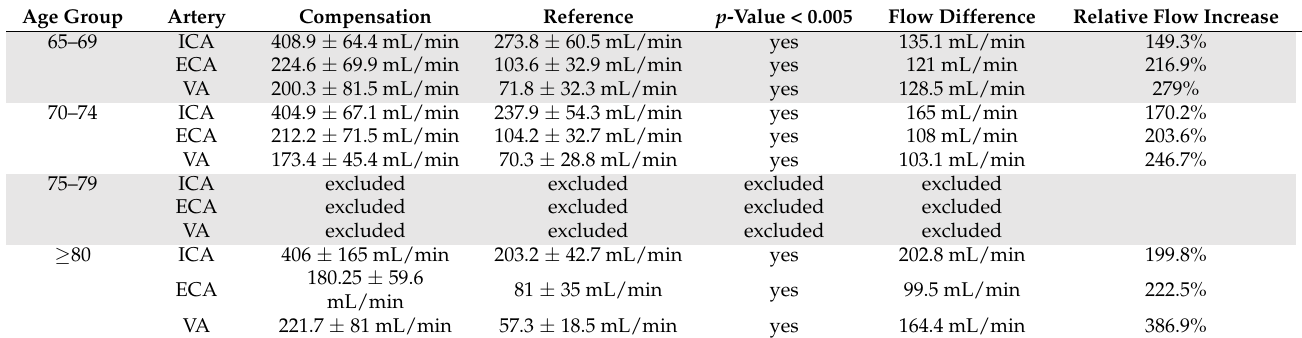
Table 4. The level of compensation in all extracranial arteries.